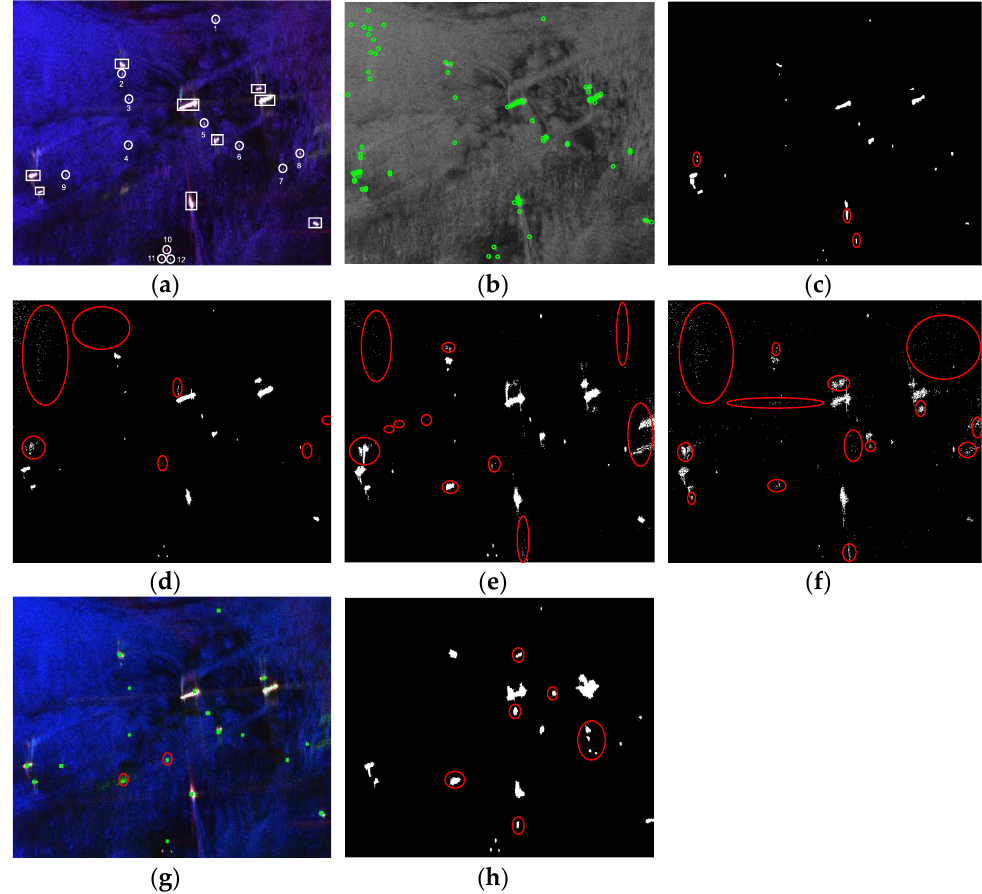
Figure 13. R5 regions: ( a ) Pauli pseudo-color image with potential targets manually marked. White rectangles indicate the strong targets and white ellipses indicate the comparatively weak targets. ( b ) Keypoints extracted by PolSAR-SIFT keypoint detector. ( c – h ) Detection results of the proposed method, the PNF, the PWF, the RS, the SD-LSMDRK, and the SD-SLLIM, respectively. The main false alarms are marked by the red circles.